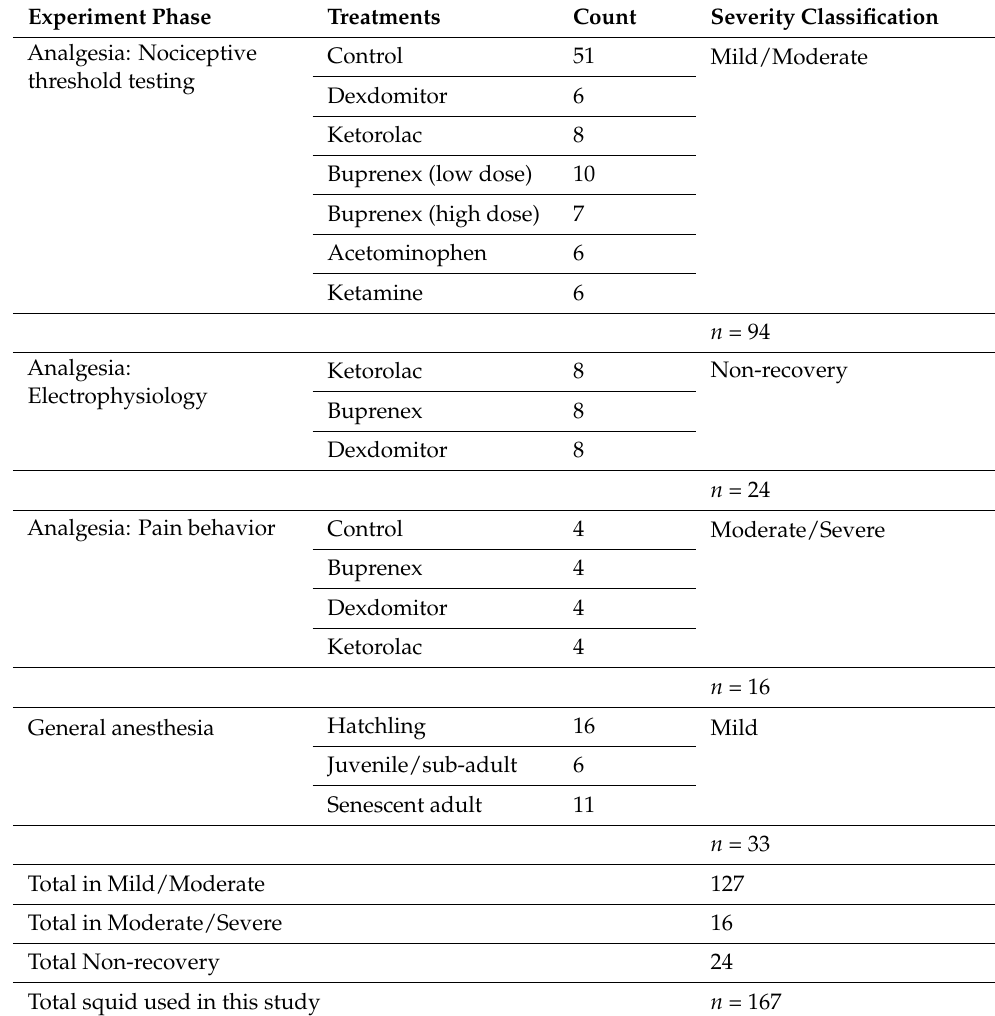
Table 1. Numbers of squid used in each phase of the study. Severity classification from